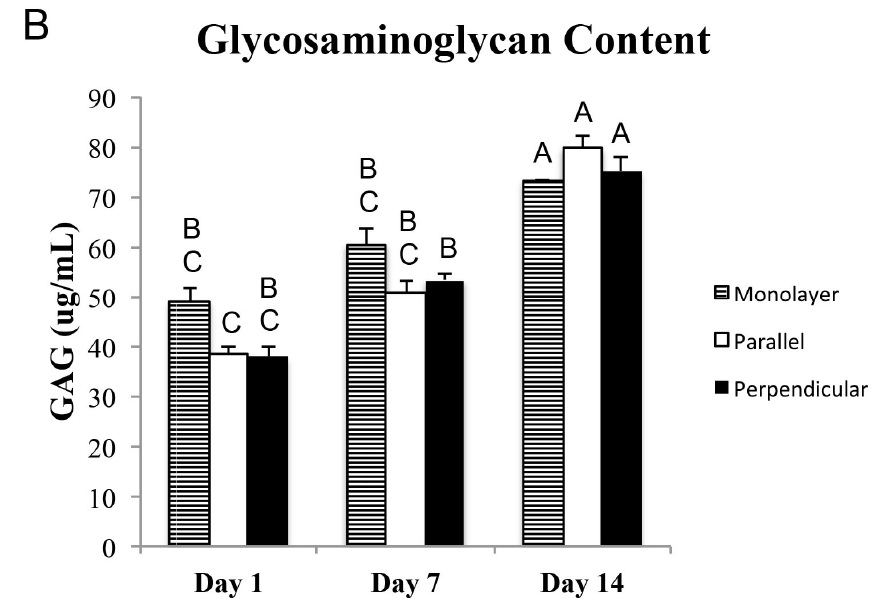
Figure 7. MSC production of the key matrix components. Collagen content quantification in media from cells in monolayer, aligned parallel scaffolds and aligned perpendicular scaffolds measured on days 1, 7, and 14 ( A ). p = 0.0038 for increased collagen production between days 1, 7, and 14, regardless of fiber orientation; GAG content quantification in media from cells in monolayer, aligned parallel scaffolds and aligned perpendicular scaffolds measured on days 1, 7, and 14 ( B ). p = 0.0038 for increased GAG production between all three days and fiber orientation. p -values ≤ 0.05 were considered significant. Groups not connected by the same letter are significantly different. Error bars represent SEM.